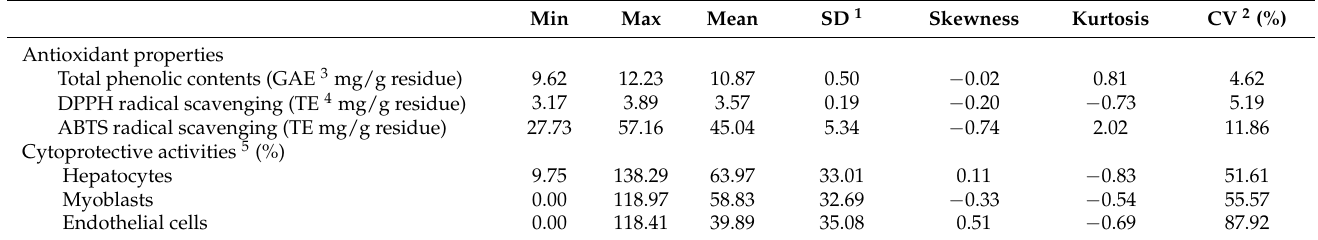
1 Standard deviation. 2 Coefficient of variation. 3 Gallic acid equivalents. 4 Trolox equivalents. 5 Hepatocytes, cy- toprotective activity in hepatocytes (HepG2); Myoblasts, cytoprotective activity in myoblasts (C2C12); Endothelial cells, cytoprotective activity in endothelial cells (EA.hy926).